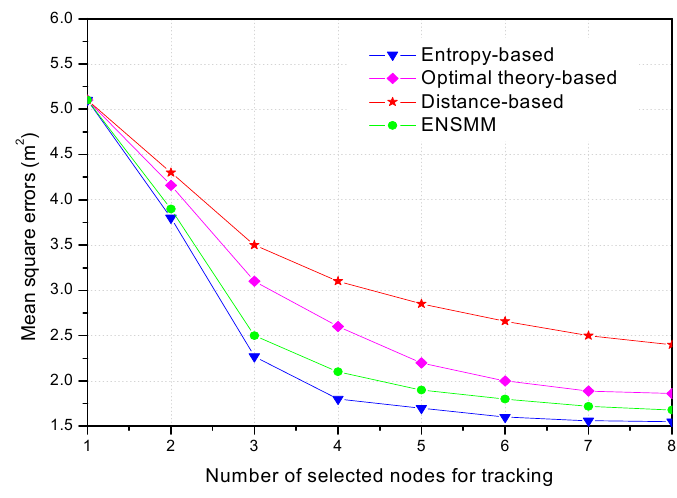
Figure 9. Mean square errors with the different number of selected nodes.